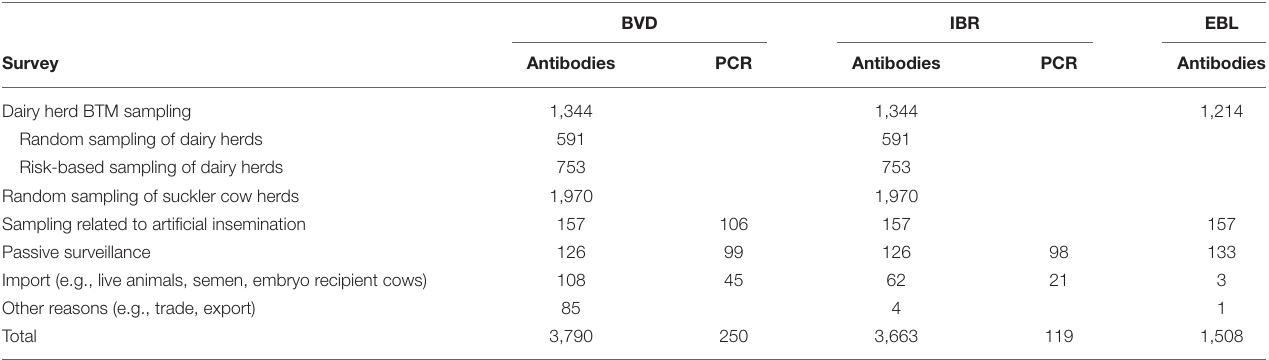
TABLE 2 | Surveillance of BVD, IBR, and EBL in Finnish cattle herds in